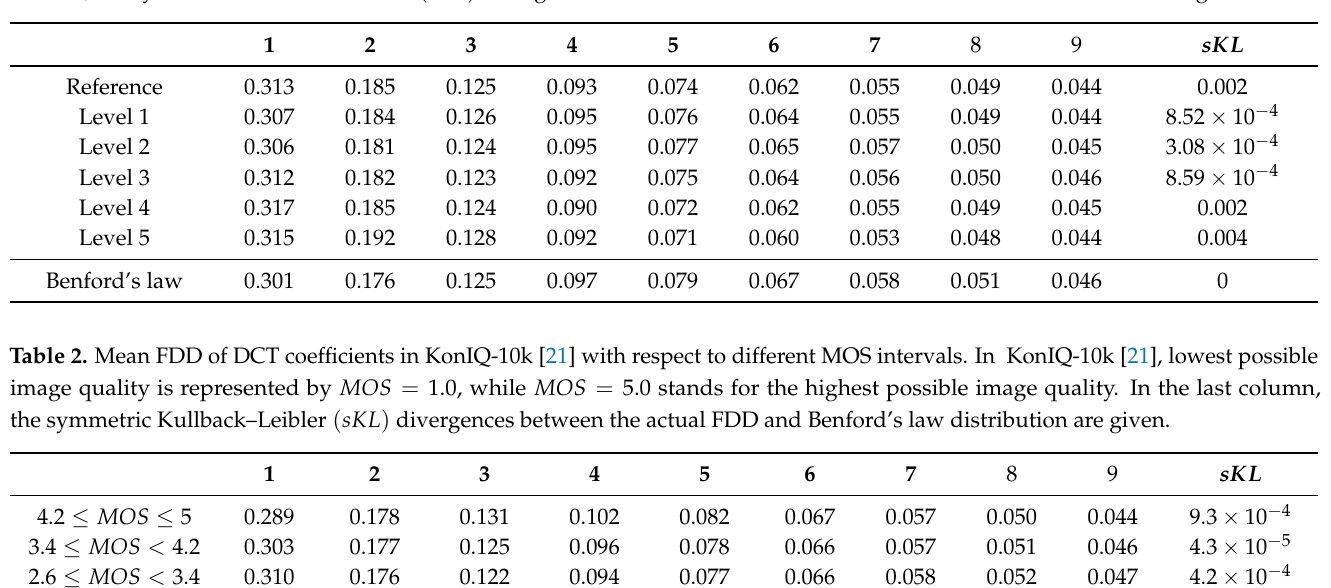
Figure 2. The algorithm framework for Benford’s law inspired NR-IQA. Table 1. Mean FDD of singular values in KADID-10k with respect to reference images and five distinct distortion levels found in KADID-10k [42]. Level 1 corresponds to the lowest amount of distortion, while Level 5 stands for the highest amount. In the last column, the symmetric Kullback–Leibler ( sKL ) divergences between the actual FDD and Benford’s law distribution are given.